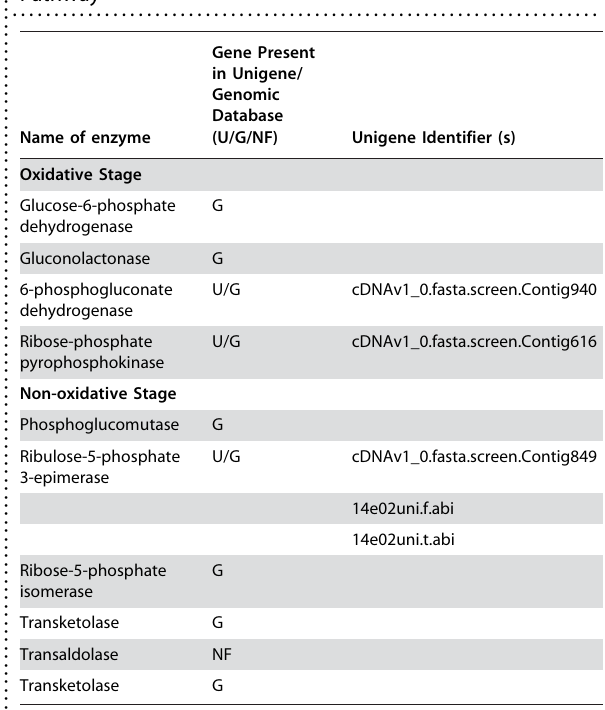
Table 4. Unigenes represented in the Pentose